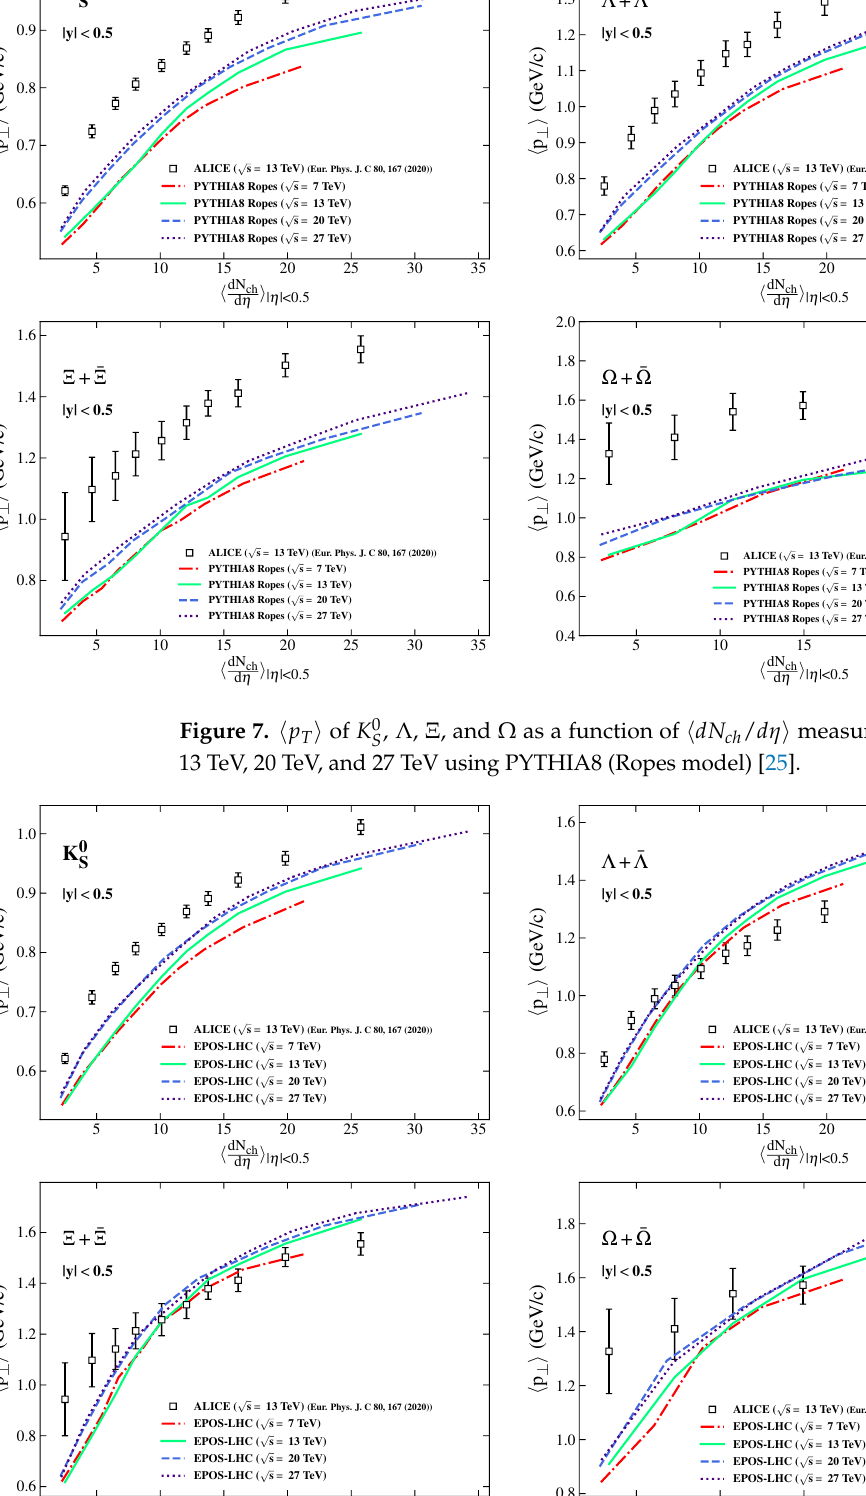
< 0.5 at √ s = 7 TeV, y | |